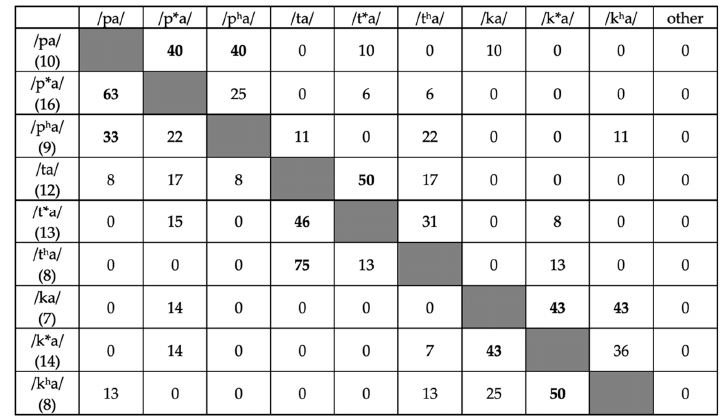
Figure A3. Confusion matrix of errors by the lead ‐ long group in the posttest for stop items (vertical = stimuli, horizontal = responses). Each cell shows the percent of all errors on the given stimulus represented by the given response (rows may not add to 100% due to rounding); the most common error type for each stimulus is bolded. The total number of errors for each stimulus (across all participants in the group) is shown in parentheses.